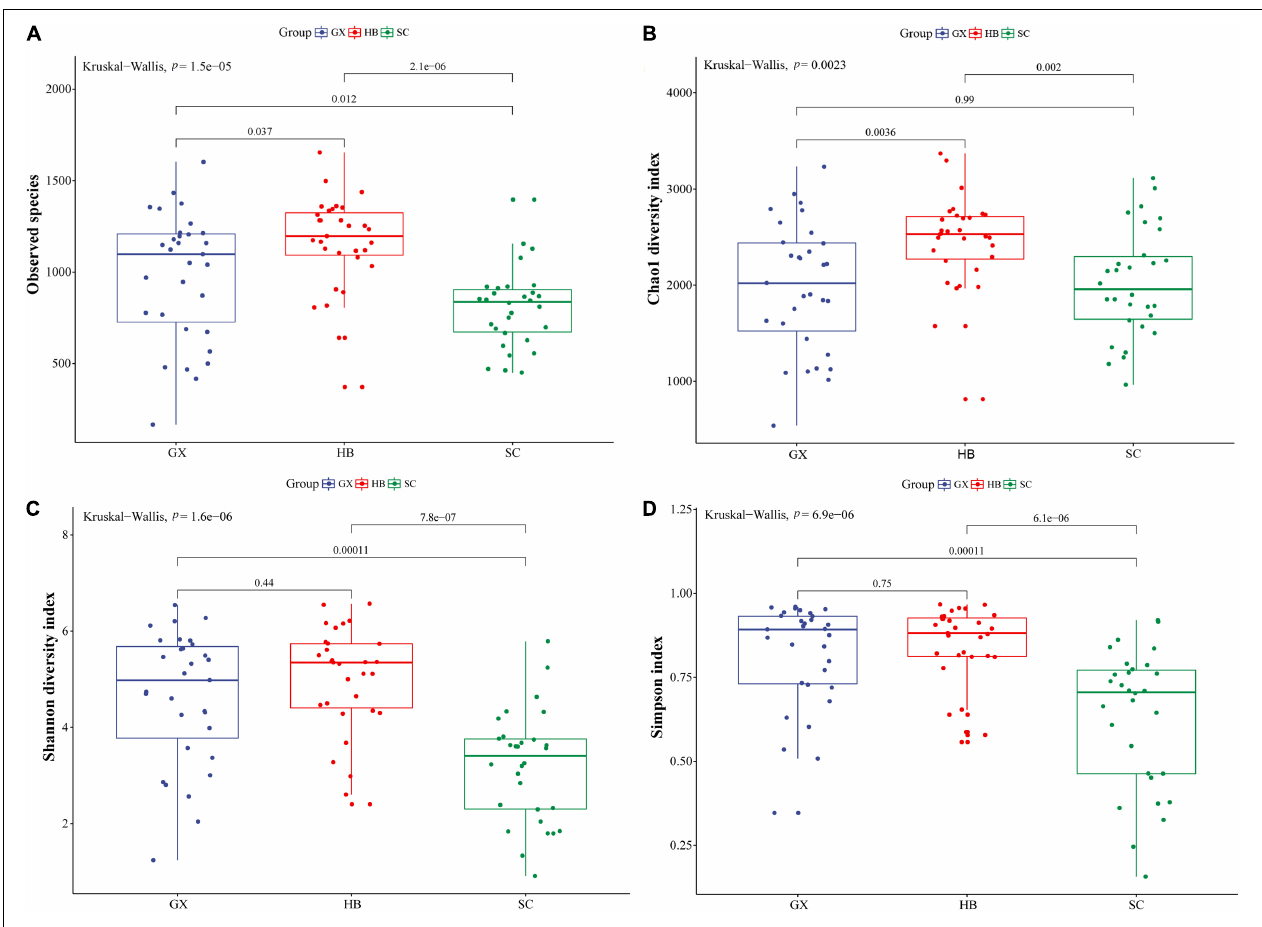
FIGURE 1 | Boxplots of α -diversity indices. (A) Number of observed species; (B) Chao1 index; (C) Shannon index; (D) Simpson index. GX, HB, and SC represent Guangxi Province, Hubei Province, and Sichuan Province, respectively. The whisker caps represent the minimum and maximum values. The box plot middle, upper, and lower lines represent the median value and first and third quartiles, respectively; values were calculated under the condition of a sequencing depth of 32,010